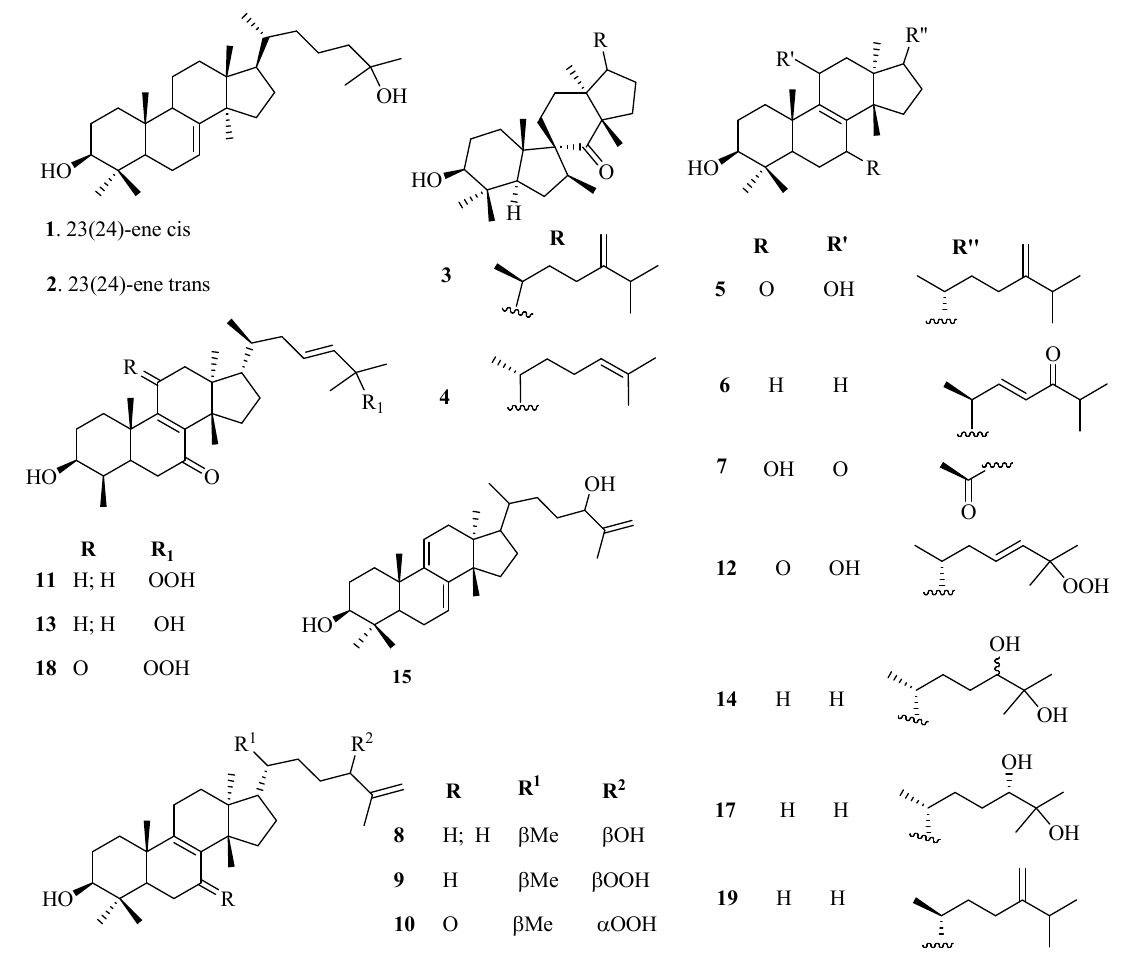
Figure 1. Chemical structures of tirucallane triterpenoids isolated from genus Euphorbia.